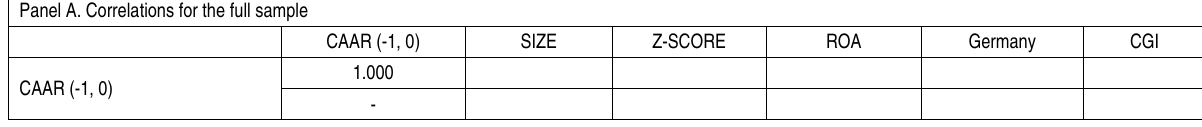
Table 7. Correlation between regression estimates variables